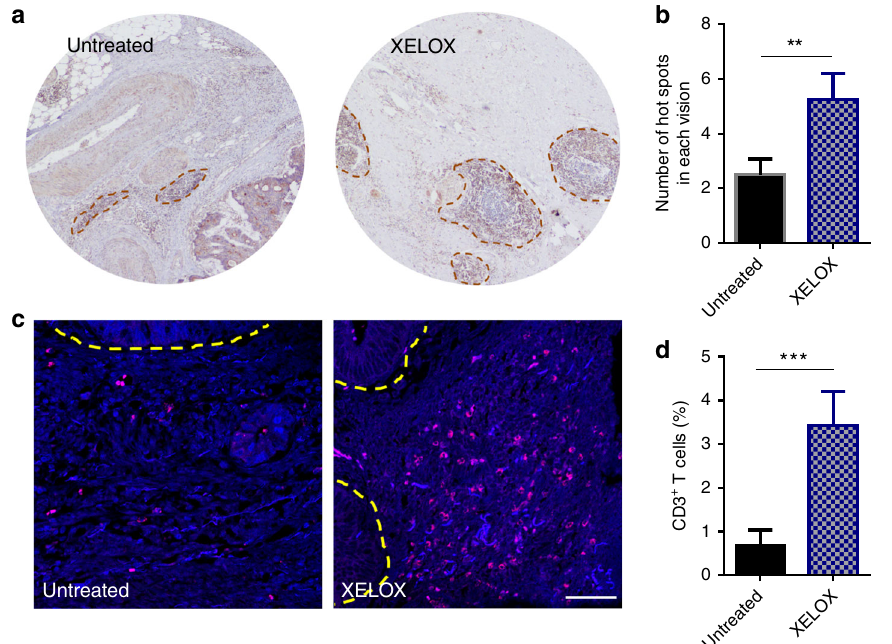
Fig. 7 MSS colorectal cancer patient sample analysis. a Representative immunohistochemistry images of tumor tissues from MSS colorectal cancer patients. Untreated represents samples from patients without any therapy. XELOX represents samples from patients after XELOX neoadjuvant chemotherapy. Images are taken at ×40 magni fi cation. Dark red circles indicate the hot spots in each visual fi eld. b Statistics of hot spots in each visual fi eld ( n = 4 samples per group). c Representative immuno fl uorescence images of tumor tissues using DAPI (blue) and anti-CD3 (red). Yellow dotted line indicates the border between intestinal mucosa and the tumor. Scale bar represents 50 μ m. d Statistics of CD3 + T cell ratios in each slice ( n = 5 samples per group). Signi fi cant differences were assessed in b and d using t test. Results are presented as mean (SD). ** P < 0.01, *** P <